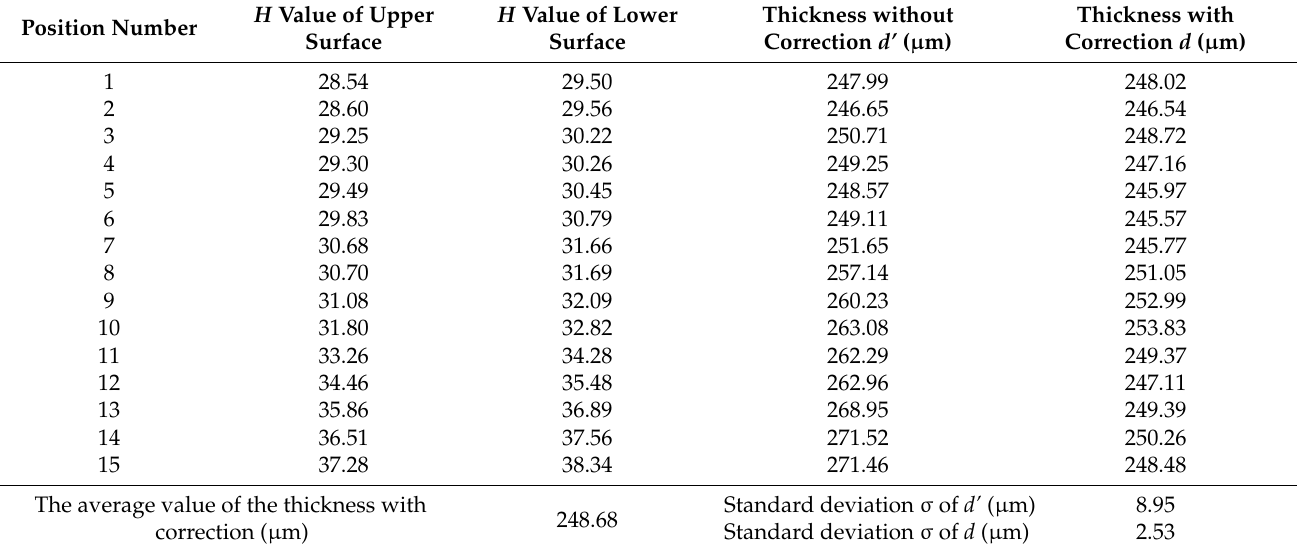
Table 7. Experimental data of the thickness of Sample